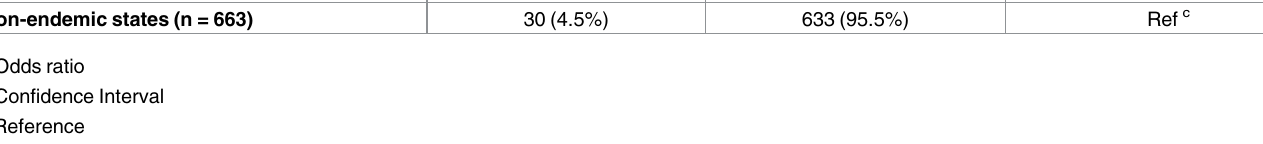
Table 4. Comparison of EIA reactivity in sera from dogs residing in endemic (Arizona), non-endemic, and newly endemic (Washington) areas. Positive Negative OR a (95% CI b ) Arizona (n = 212) 43